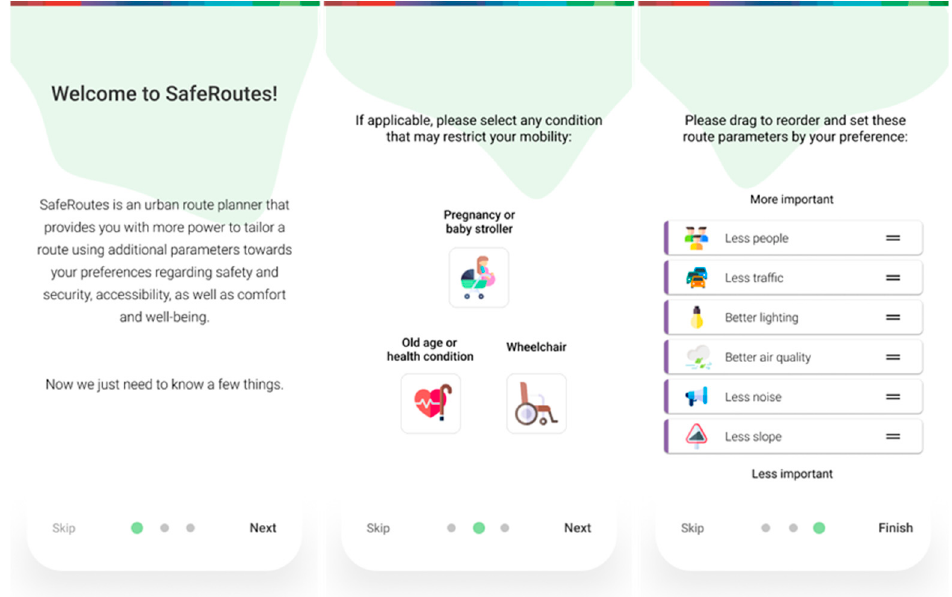
Figure 3. Screens for the introduction to the route planner with onboarding questions.